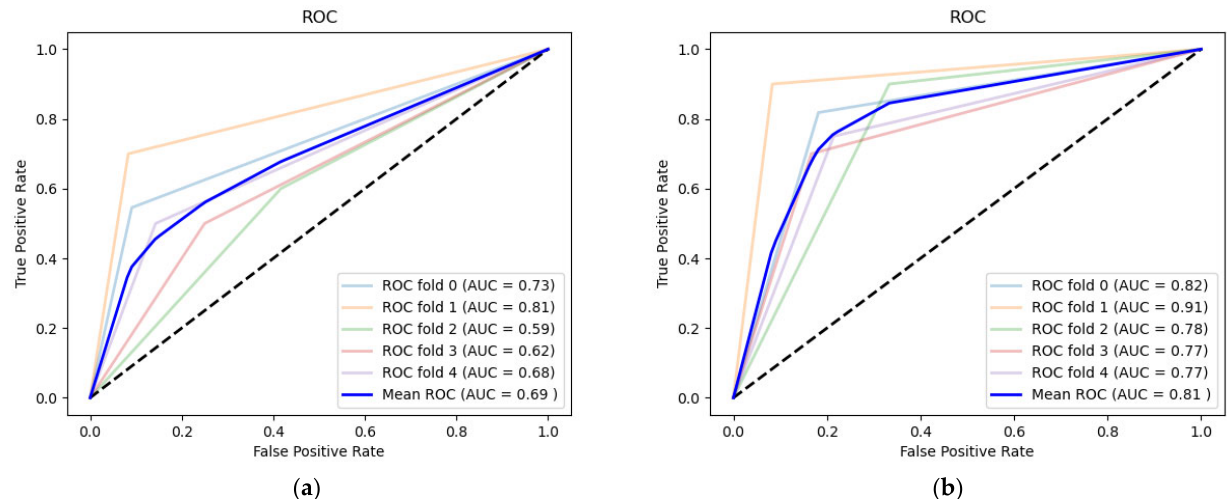
Figure 8. ROC curve of DT: ( a ) non ‐ feature selection; ( b ) IG.